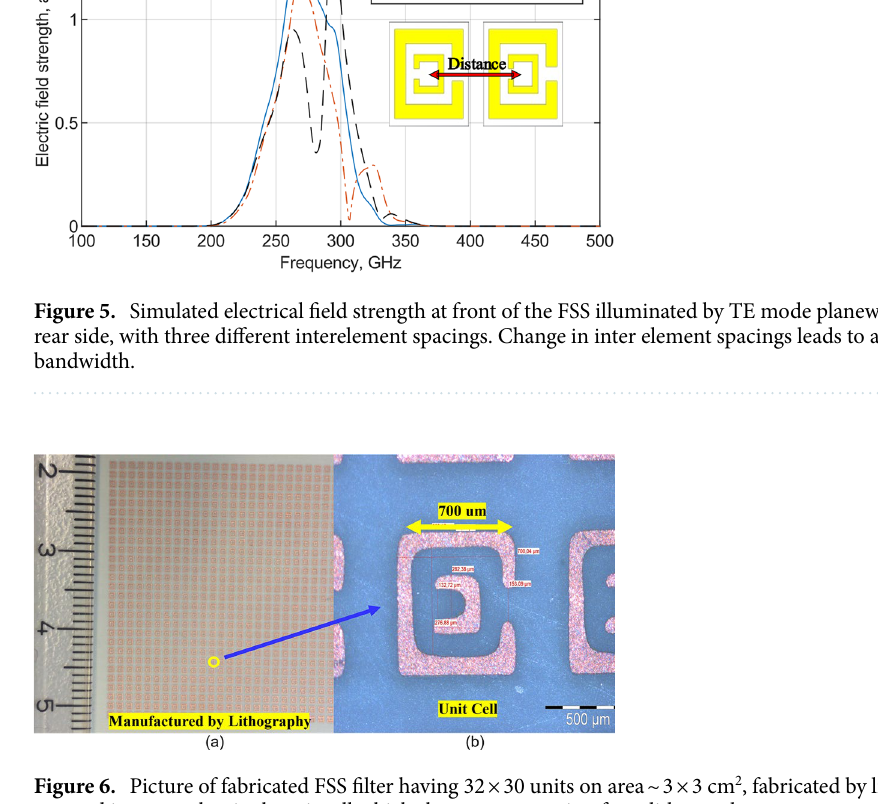
Figure 6. Picture of fabricated FSS filter having 32 × 30 units on area ~ 3 × 3 cm 2 , fabricated by lithography and zoomed image to the single unit cell which shows some erosion from lithography.